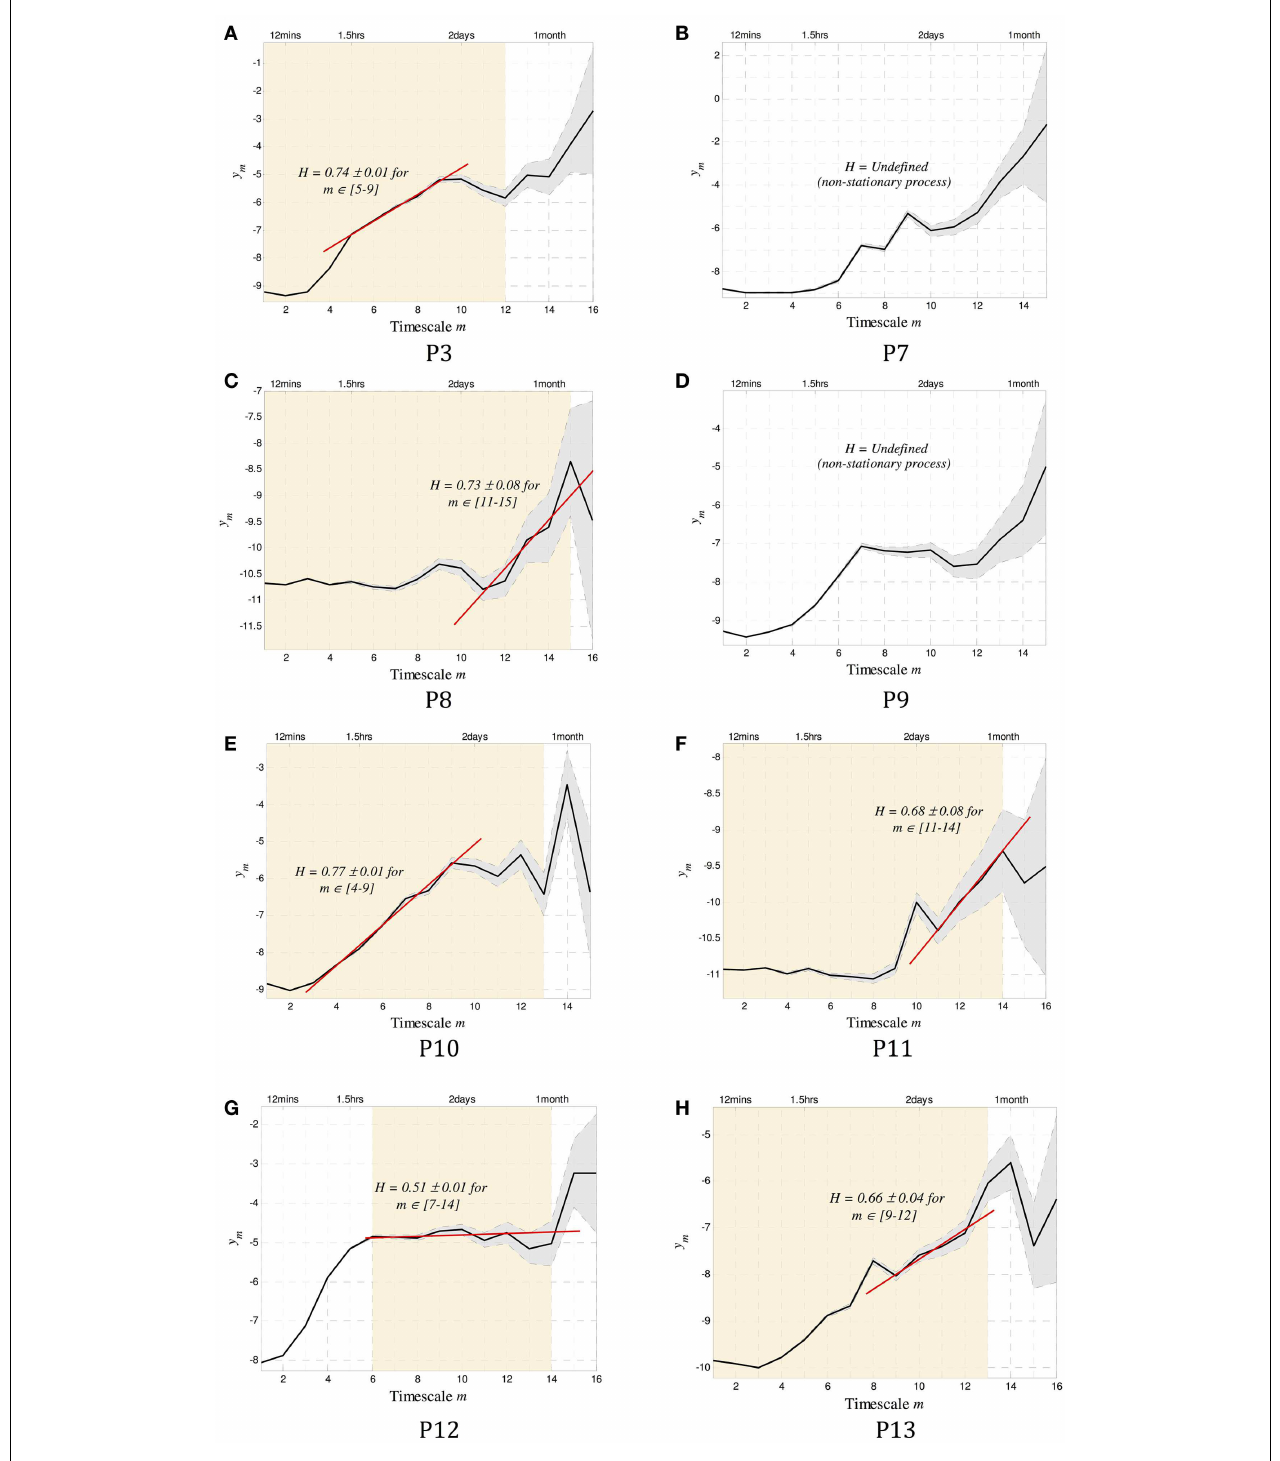
from 0.66 to 0.77.The last subject (P7) showed potentially random correlations between time scales ( H = 0.51 ± 0.01). Note that to infer stationarity for P7, the data were divided into three segments containing ~1500 events each. At the small time scales, two of the segments agreed with the results, and one did not.This may imply a sharp dynamic change occurring sometimes during the 1.8years of recording. A summary of all results can be found in Table 2